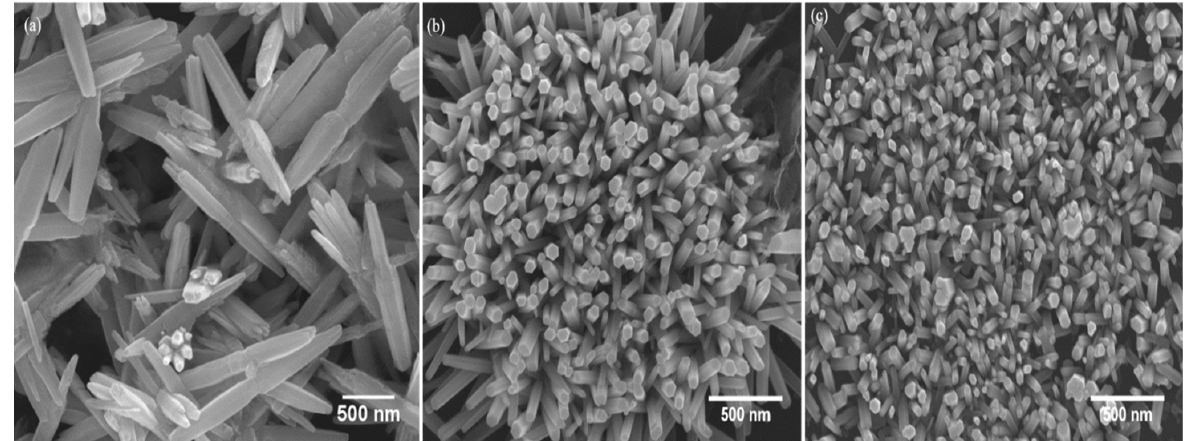
Figure 2. FESEM images of the ZnO nanowires grown on ZnO seed layer thickness of ( a ) one ‐ layer sample, ( b ) three ‐ layer sample, and ( c ) five ‐ layer sample.